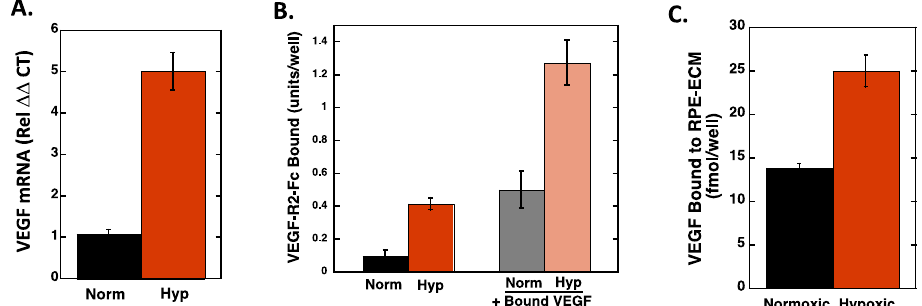
Figure 3. Hypoxia increases VEGF expression, VEGF deposition in the ECM, and VEGF binding in RPE cells. RPE cells were subjected to normoxia and hypoxia for 72 h. ( A ) Total RNA was extracted from RPE cells and mRNA quantified using qPCR analyses, as described in Materials and Methods. The data is normalized to the 18S RNA and to the normoxic control for each condition and expressed as the average ± SEM. ( N = 4; n = 2). ( B ) After the normoxic/hypoxic conditioning, RPE cells were washed and incubated with and without 50 ng/mL VEGF for 1 h at 4 °C. Unbound VEGF was removed from the cells by washing and the cells were subsequently incubated with Fc-VEGFR2 Chimera. Bound Fc-VEGF-R2 was detected with an HRP-linked secondary antibody. The data are expressed as average background corrected absorbance values ± SD ( N = 4). ( C ) 125 I-VEGF was bound to normoxia/hypoxia were RPE cells and the amount bound to the ECM extracted and quantitated. Data represent the average ± SD of quadruplicate wells ( N = 4). Hypoxia induced a statistically significant increase in VEGF mRNA ( A ), VEGFR2 binding ( B ), and VEGF increased VEGFR2 binding to both normoxic and hypoxic cells ( B ), and hypoxia increased VEGF binding to the ECM of RPE cells.